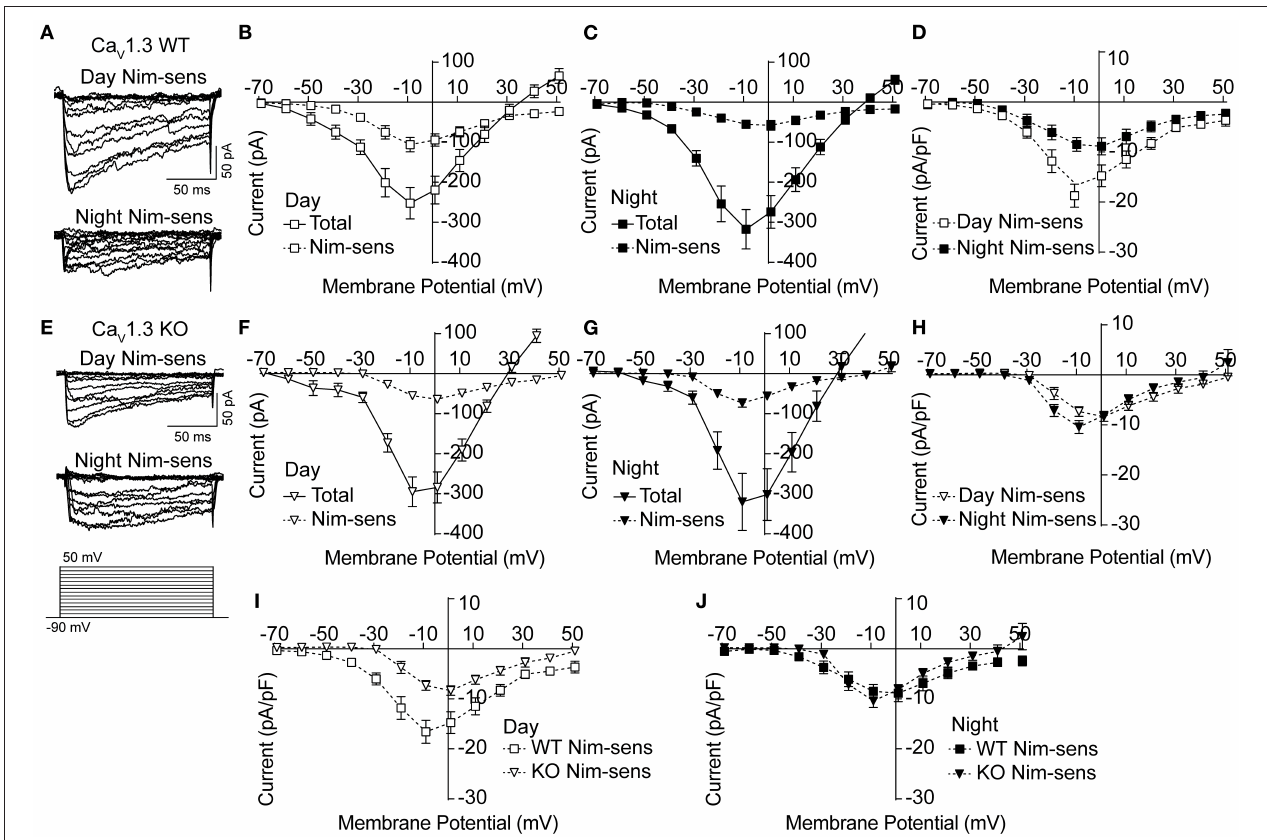
FIGURE 2 | Nimodipine-sensitive Ca 2 + currents from Ca V 1.3 WT and Ca V 1.3 KO SCN during the day and night. Macroscopic Ca 2 + currents were elicited from a holding potential of − 90mV by 150-ms voltage steps from − 90 to + 50mV in + 10-mV increments. Nimodipine-sensitive LTCC currents were isolated by subtracting currents obtained in 10 µ M nimodipine from the total cell current. (A,E) Representative nimodipine-sensitive (Nim-sens) current traces from Ca V 1.3 WT (A) and Ca V 1.3 KO (E) neurons during the day (top current traces) and night (bottom). (B,C) Current-voltage plot for Ca V 1.3 WT Ca 2 + currents before nimodipine (total) and the nimodipine-sensitive (Nim-sens) current from day (B) and night (C) neurons. (D) Comparison of Ca V 1.3 WT nimodipine-sensitive normalized current density between day and night. Ca V 1.3 WT nimodipine-sensitive currents were larger during the day (at − 10mV) compared to night (at 0mV) ( P = 0.01). (E) Representative nimodipine-sensitive currents from Ca V 1.3 KO neurons during the day (top current traces) and night (bottom). (F,G) Current-voltage plot of Ca V 1.3 KO total and nimodipine-sensitive currents from day (F) and night (G) neurons. (H) Comparison of Ca V 1.3 KO nimodipine-sensitive normalized current density between day and night. Ca V 1.3 KO nimodipine-sensitive currents were not different between day (at 0mV) and night (at − 10mV) ( P = 0.2). (I,J) Comparisons of nimodipine-sensitive current densities from Ca V 1.3 WT and Ca V 1.3 KO SCN during the day (I) and night (J) . Ca V 1.3 KO nimodipine-sensitive currents were smaller than Ca V 1.3 WT currents during the day ( P = 0.009) but not at night ( P = 0.5). P < 0.05, unpaired Welch’s t tests. N’s represent individual cells recorded from Ca V 1.3 WT (eight neurons, three slices day; 10 neurons, four slices night) and Ca V 1.3 KO (12 neurons, two slices day; nine neurons, one slice night). Data are mean ±